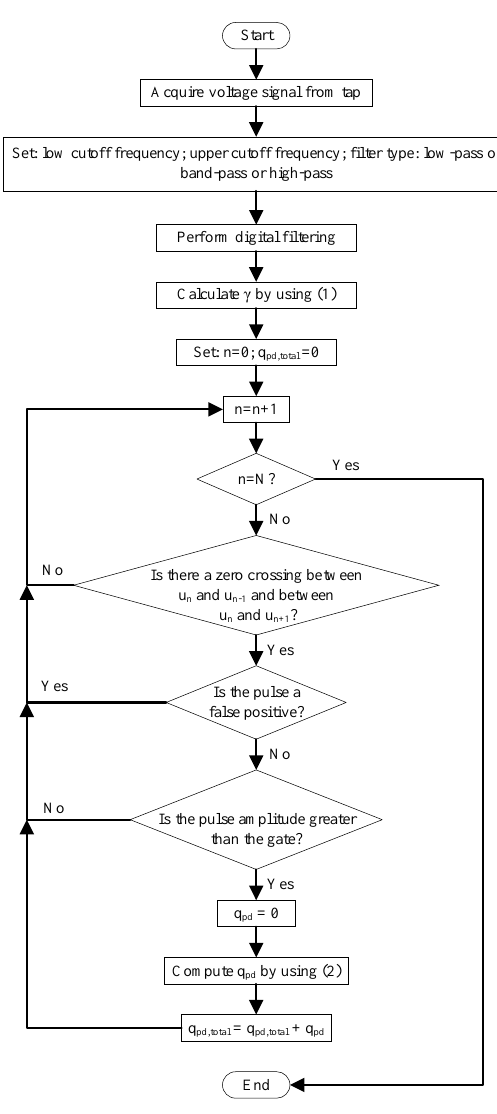
Figure 11. Flowchart for the calculation of apparent charge.